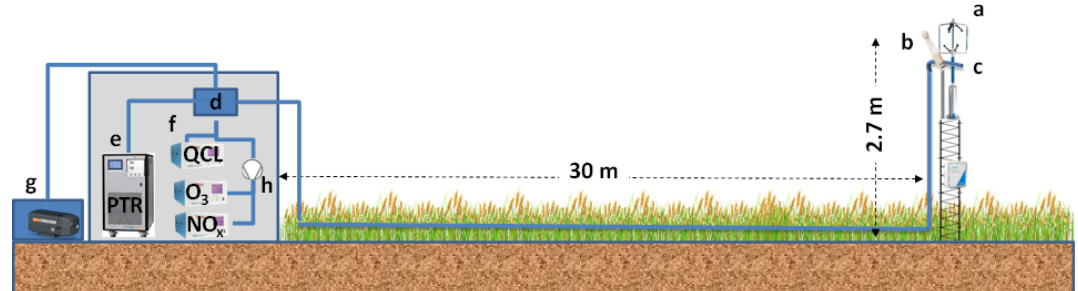
Figure 2. The eddy covariance VOC measurement setup, showing (a) the ultrasonic anemometer, (b) the CO 2 and H 2 O open-path analyser, (c) the heated sampling line inlet, (d) the heated manifold, (e) the PTR-Qi-TOF-MS, (f) the gas analysers, (g) the high-volume vacuum pump, and (h) the teflonized subsampling pump. Diagram not to